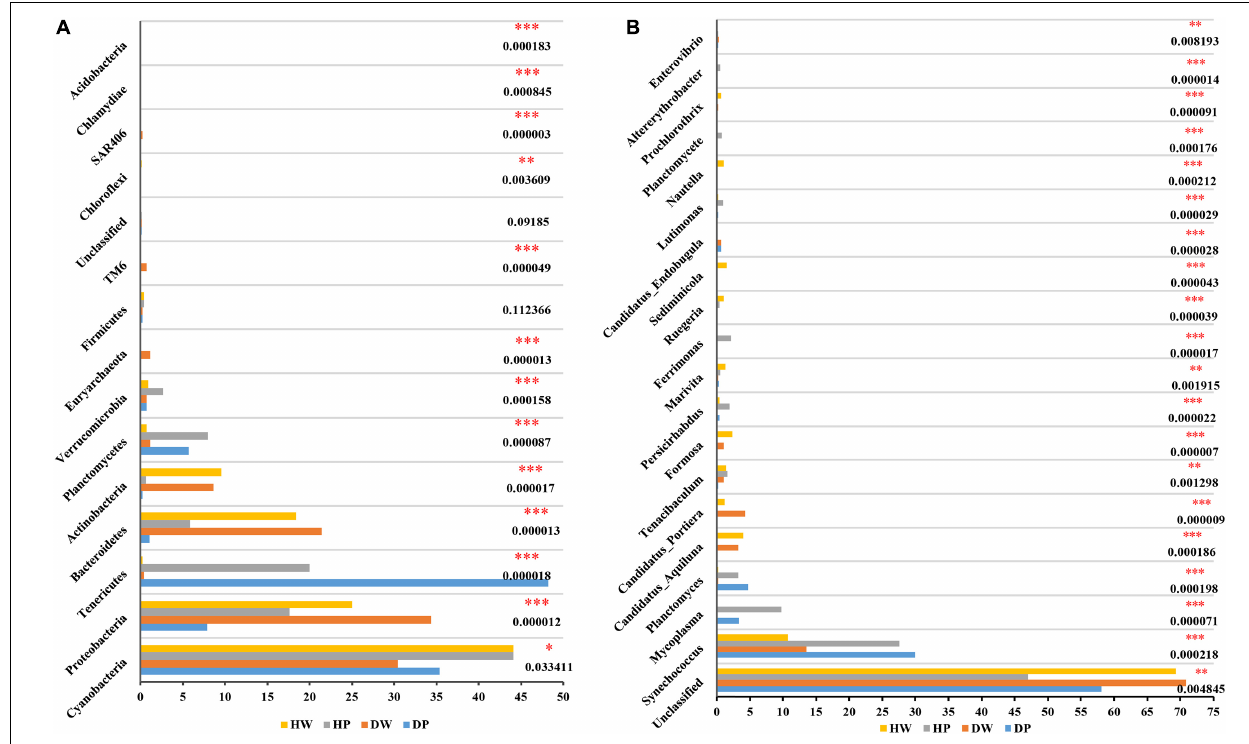
FIGURE 4 | Comparison of bacterial abundances among HW, HP, DW, and DP at the phylum level (A) and genus level (B) . ∗ 0.01 < p ≤ 0.05, ∗∗ 0.001 < p ≤ 0.01, and ∗∗∗ p ≤ 0.001.